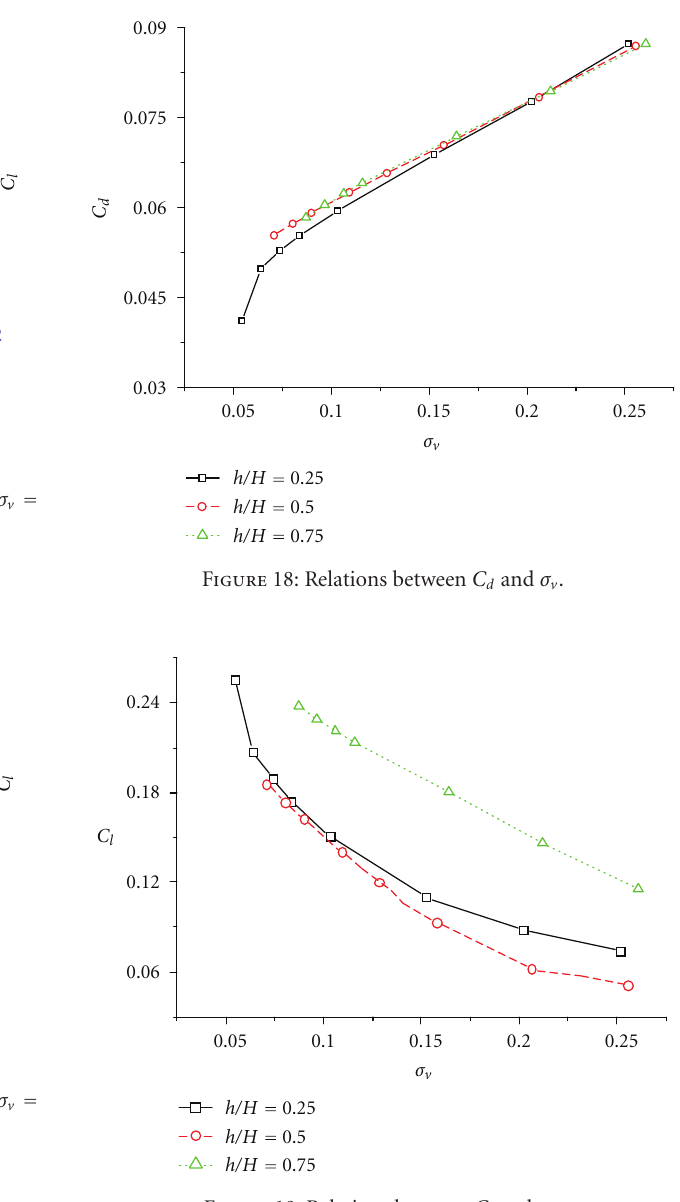
Figure 19: Relations between C l and σ v